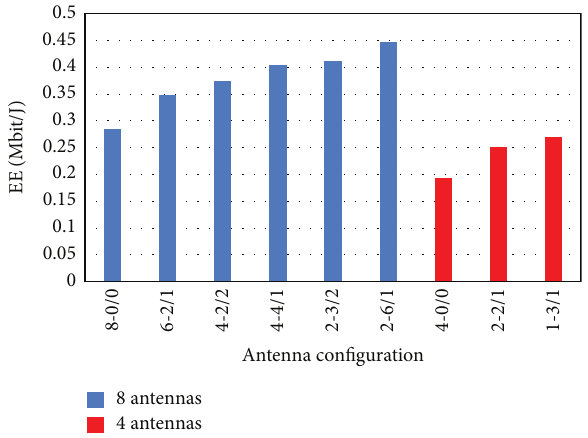
Figure 3: EE of CAS and DAS with different number of anten- nas/RRUs. High load scenario and 𝐵 𝑤 = 1.4